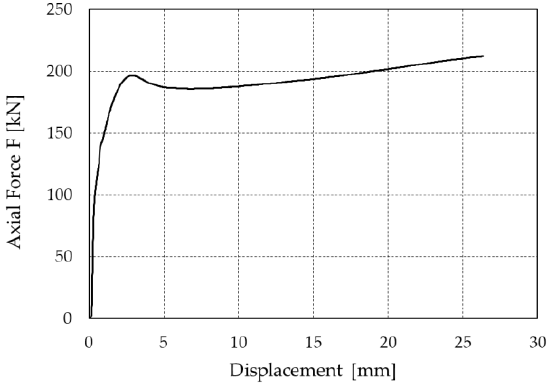
Figure 4. Force – displacement curve of the PS-LED prototype evaluated in the Ramp test. Figure 4. Force–displacement curve of the PS-LED prototype evaluated in the Ramp